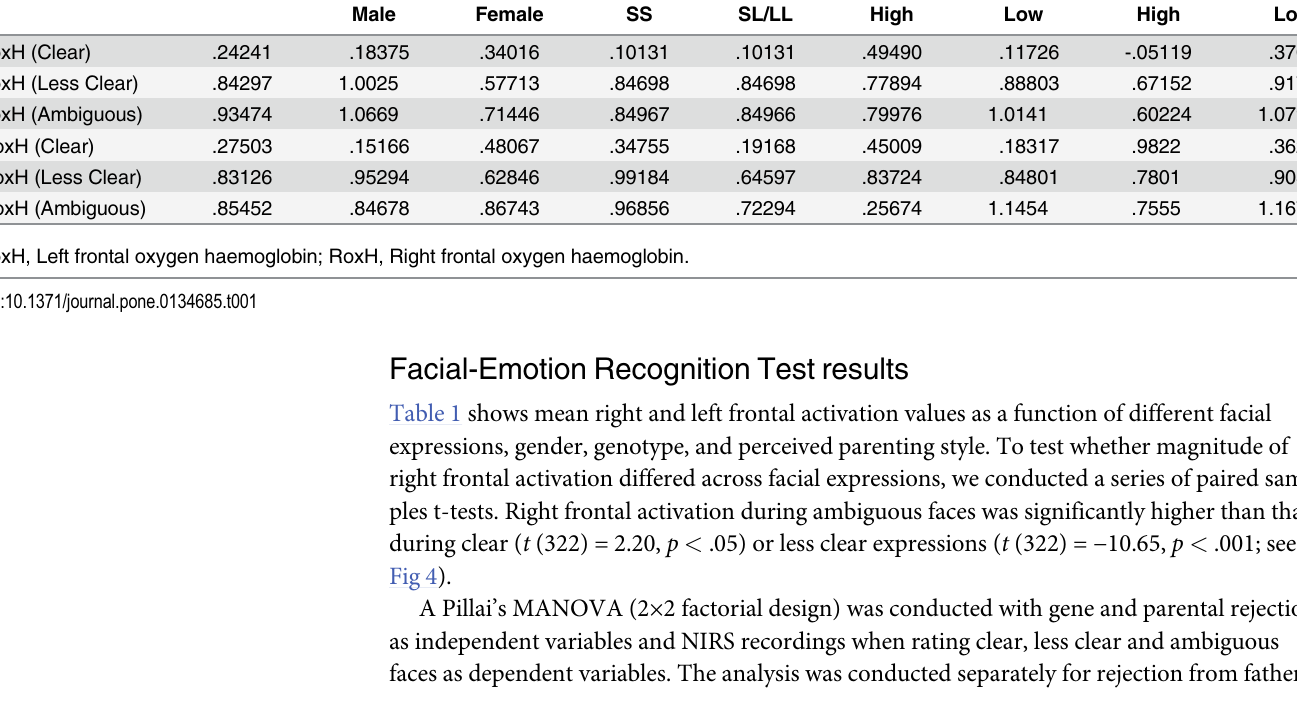
Table 1. Mean values of right and left frontal activation on different levels of facial tasks divided in gender, genotype, and perceived parenting. Factors